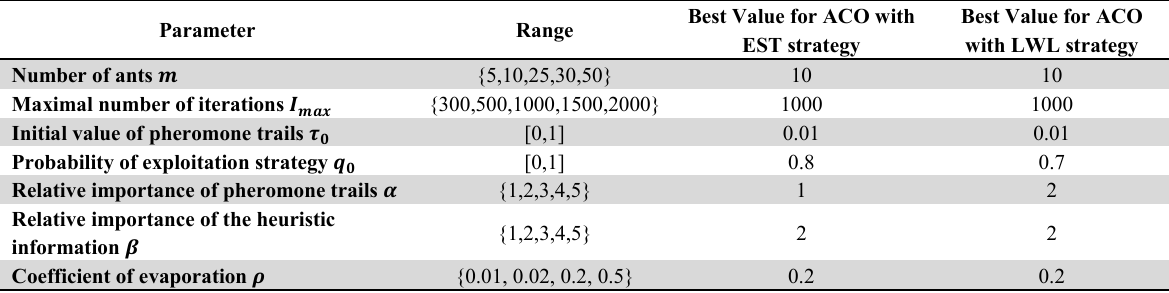
Best combinition of